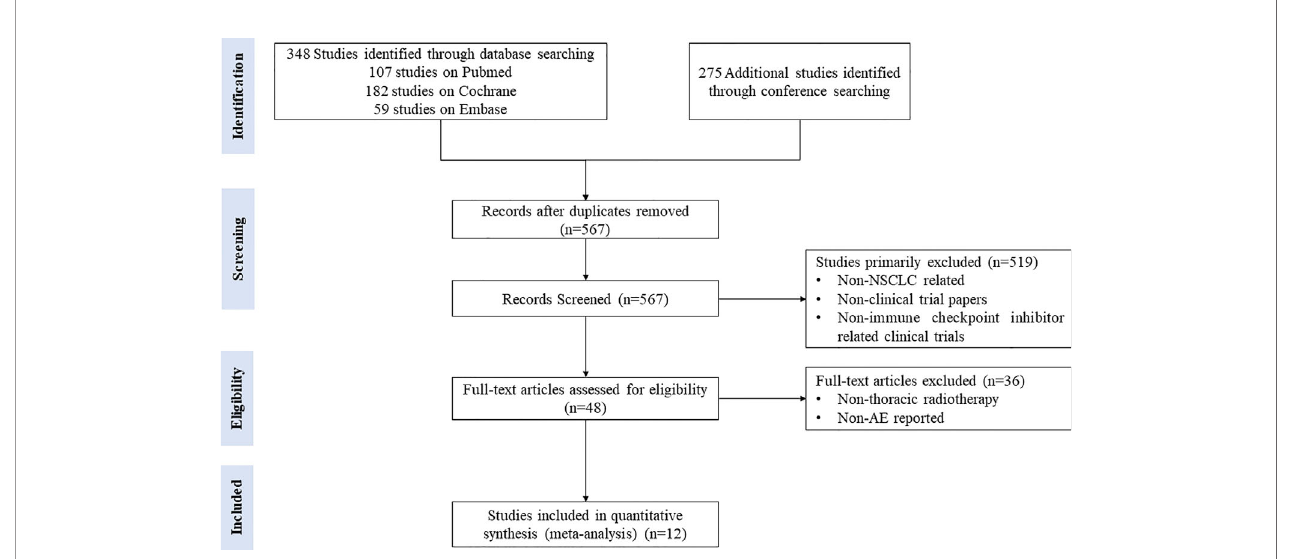
FIGURE 1 | Flow diagram of study